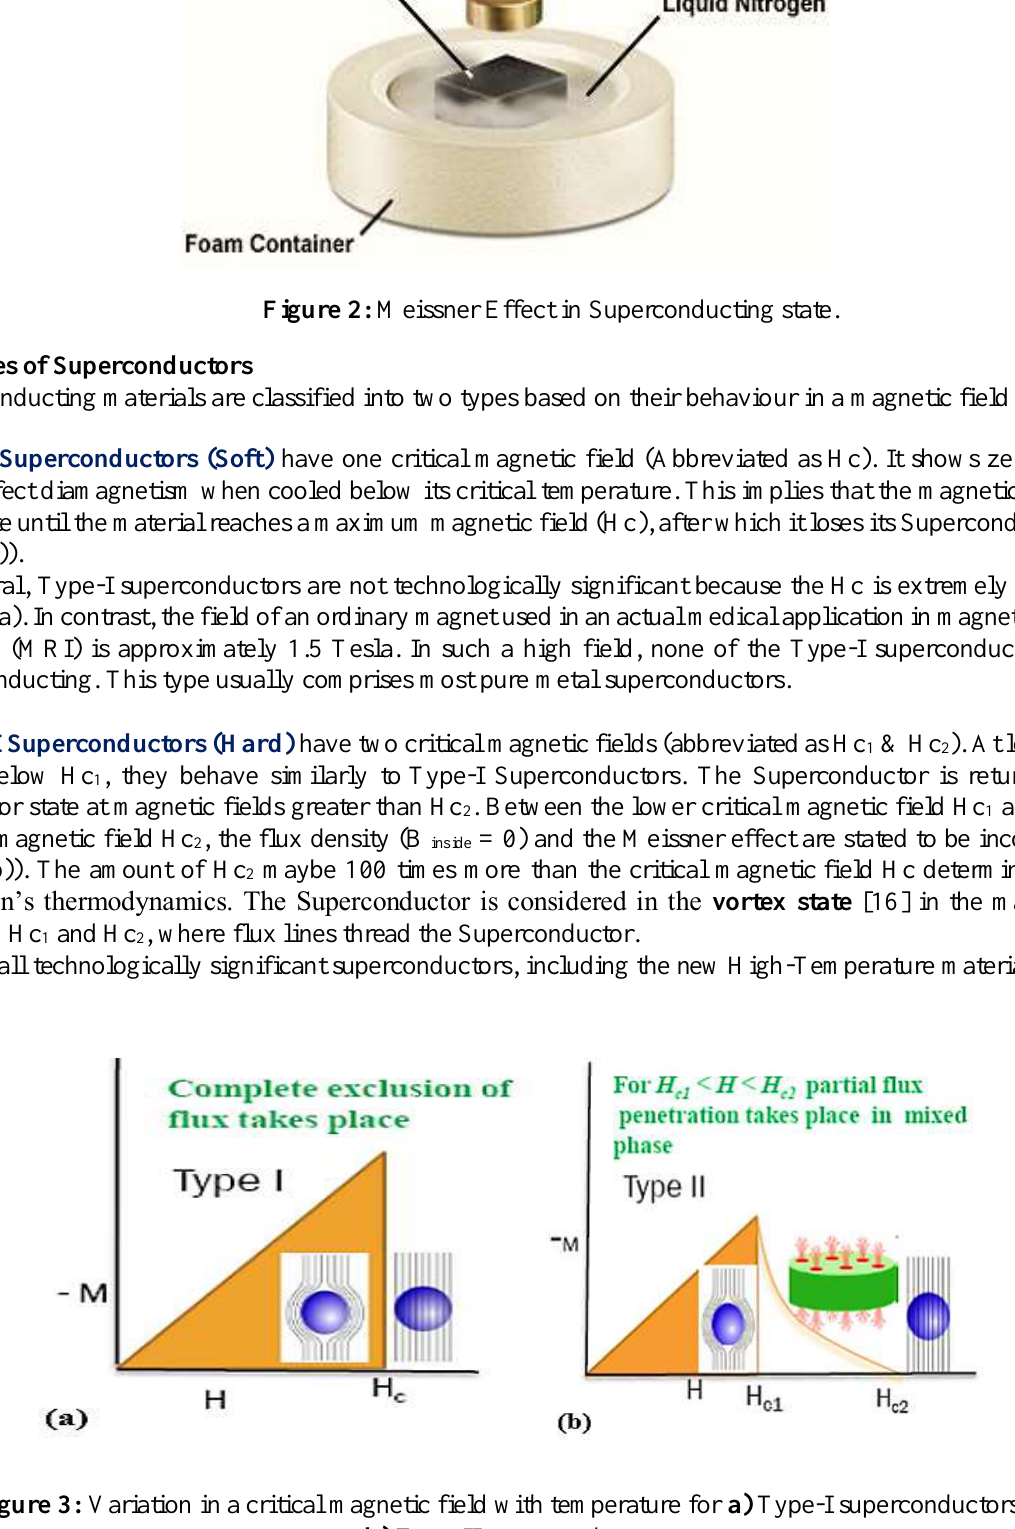
Figure 3: Variation in a critical magnetic field with temperature for a) Type-I superconductors and b) Type-II